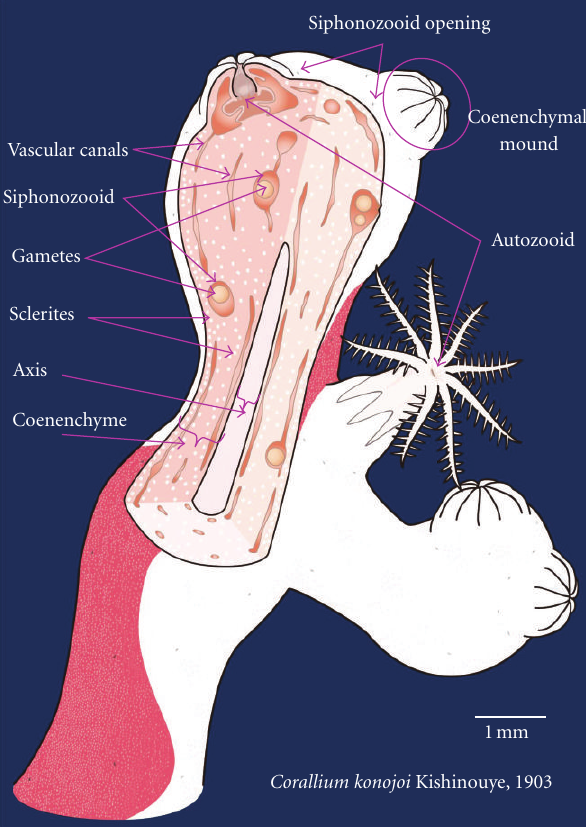
Figure 30: Diagrammatic section through a branchlet of Corallium konojoi , showing coenenchyme and